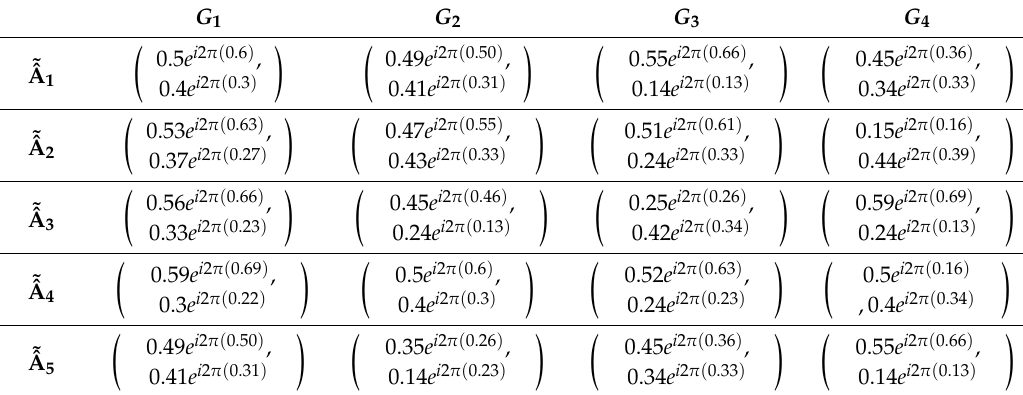
Table 1. Decision matrix for Example